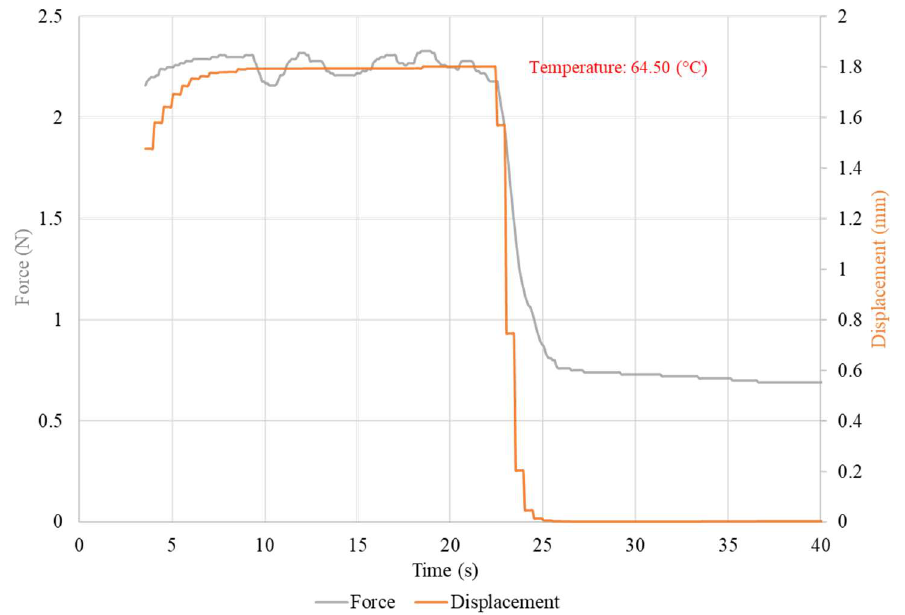
Figure 5. Waveform of the measurement with a 200 mA heating current with the average temperature of the heated sample. Sample diameter, 100 μm.